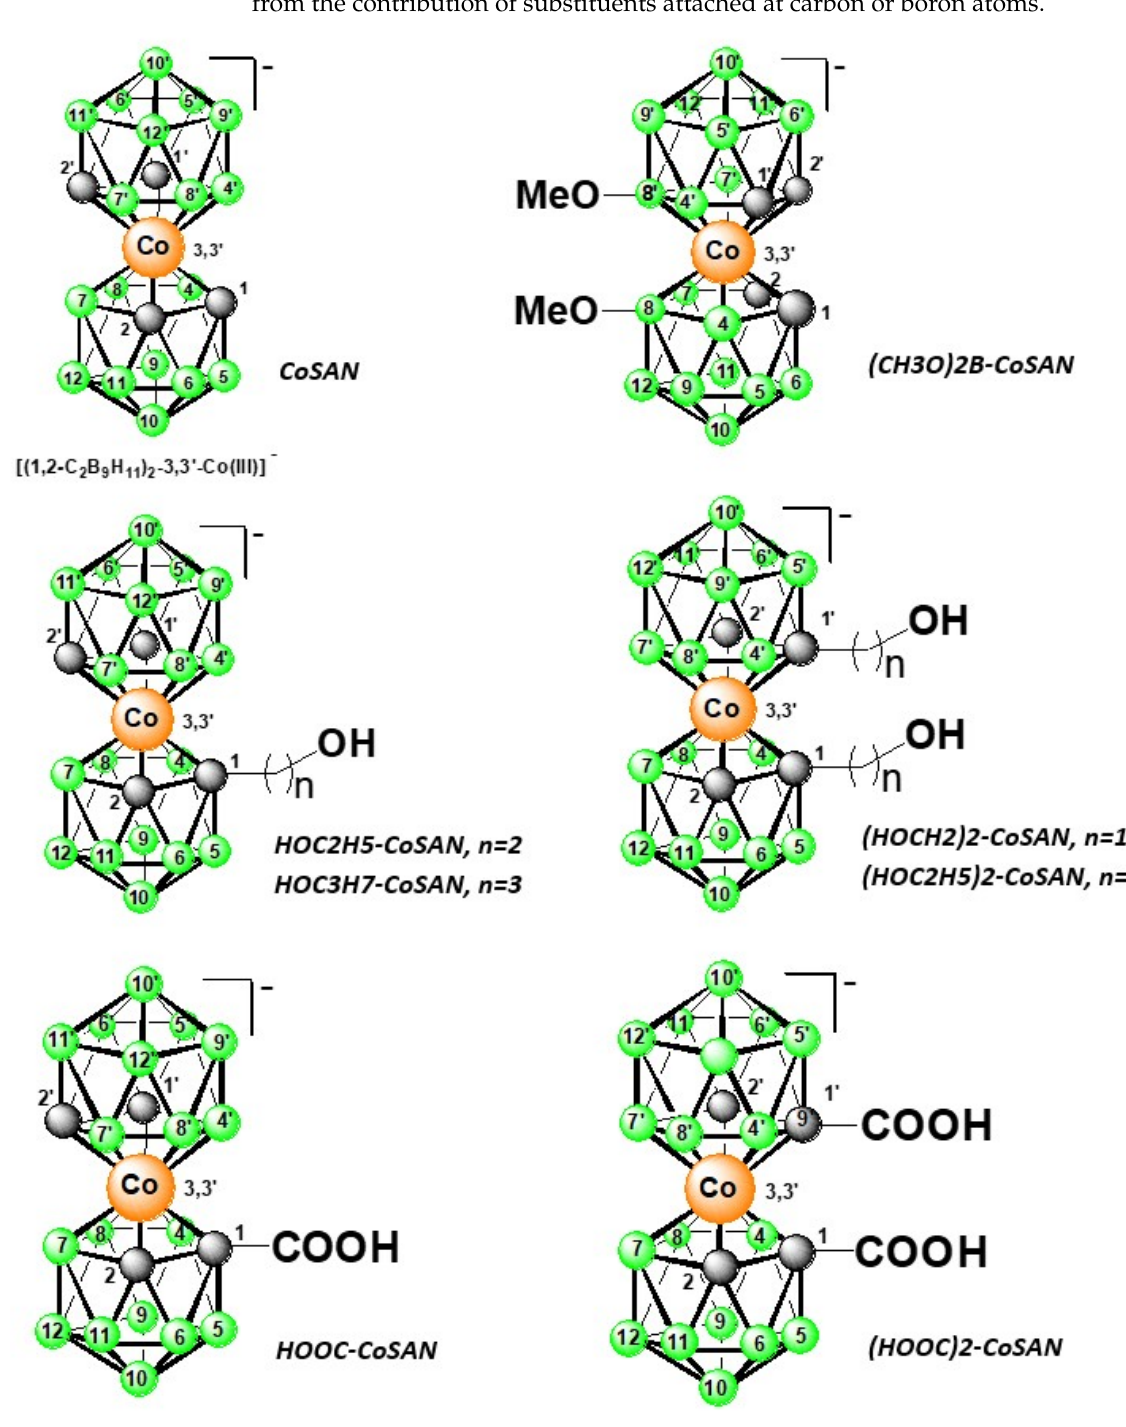
Figure 1. Schematic structural formulas of the metallacarboranes and all used exo -skeletal substituents. For all cases, black ball — CH group; green ball — BH group.